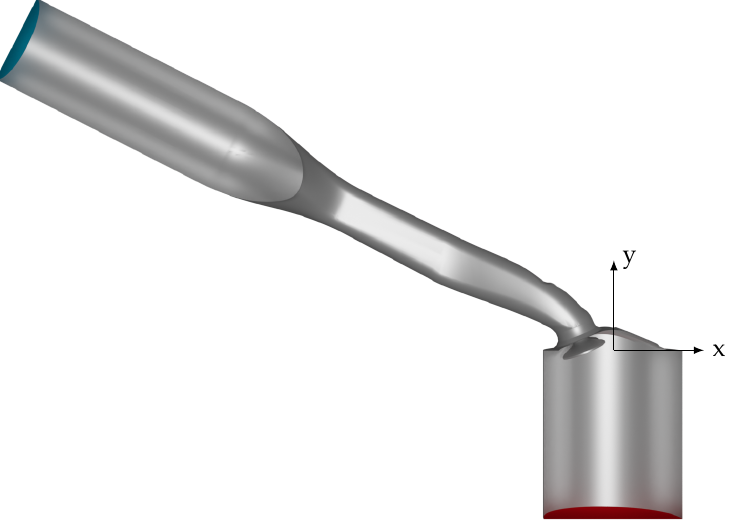
Figure 4. Clip representation of the simulation geometry with (x,y)-plane coordinate system. The boundary contains inlet (blue), outlet (red) and wall patches